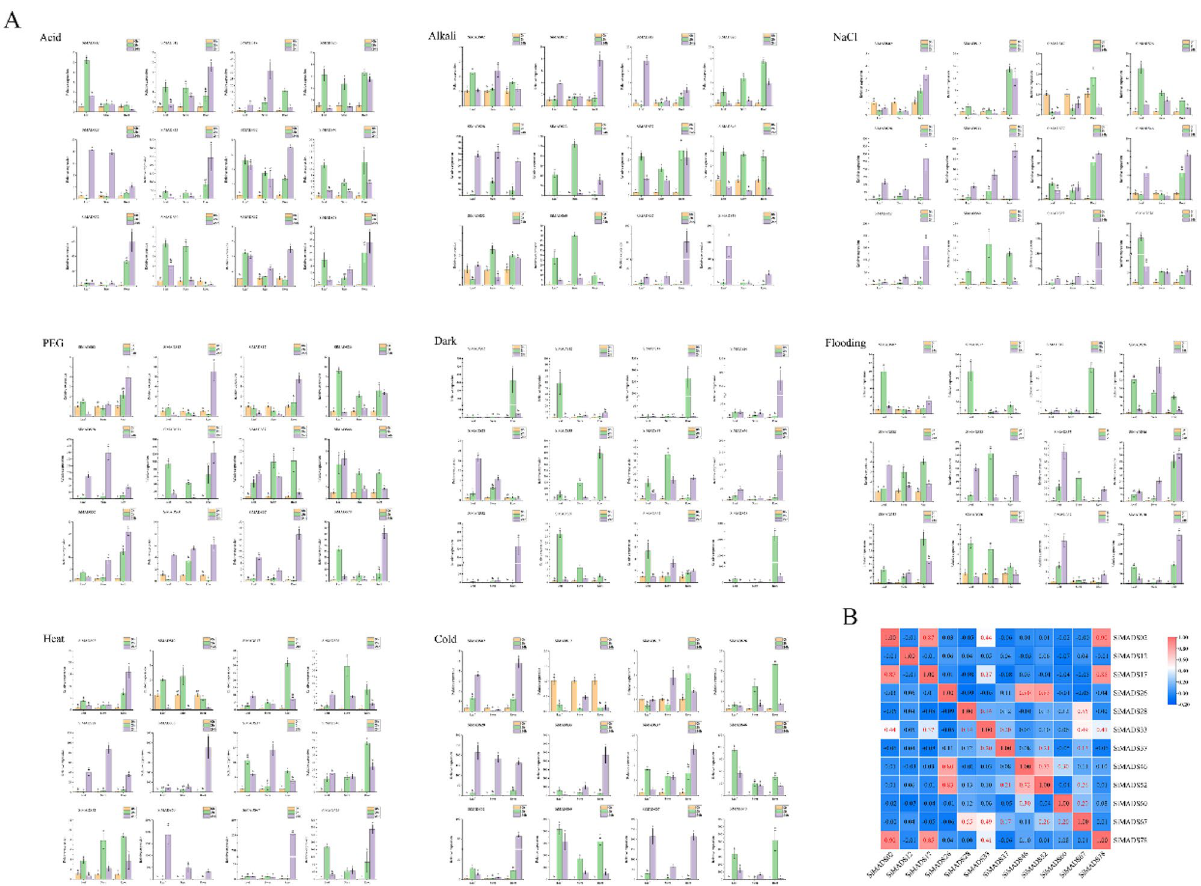
Figure 9. Gene expression of 12 S. italica MADS-box genes in plants subjected to abiotic stresses (acid, alkali, NaCl, PEG, dark, flooding, heat, cold) at the seedling stage. ( A ) qRT-PCR was used to detect the expression patterns of 12 S. italica MADS-box genes in roots, stems and leaves at different times. Error bars were obtained from three measurements. Lowercase letter above the bar indicates significant difference (α = 0.05, LSD) among treatments. ( B ) Positive number: positively correlated; negative number: negatively correlated. Red numbers indicate a significant correlation at the 0.05